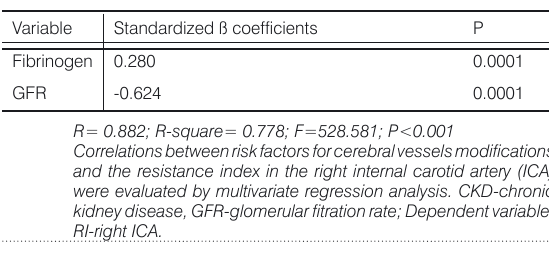
Table 5. Correlations between risk factors and the resistance indices in the internal carotid arteries in CKD(+) patients.